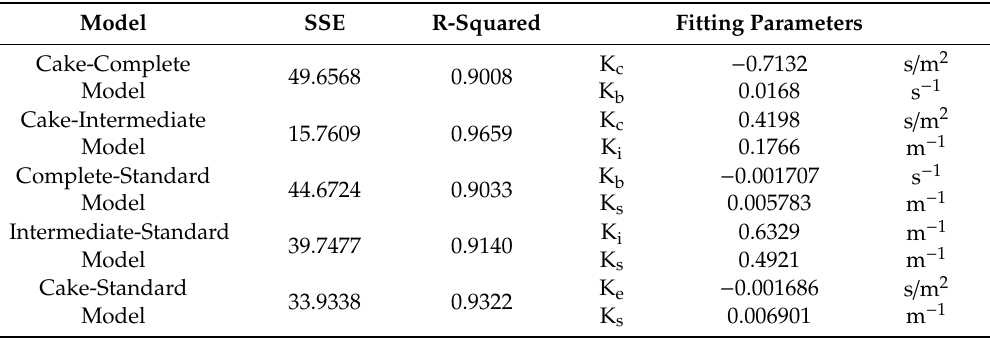
Figure 8. Curve fitting of the observed TMP data with the combined models. Table 4. Linear parameters, correlation coe ffi cients and model parameters for the five combined models using in this